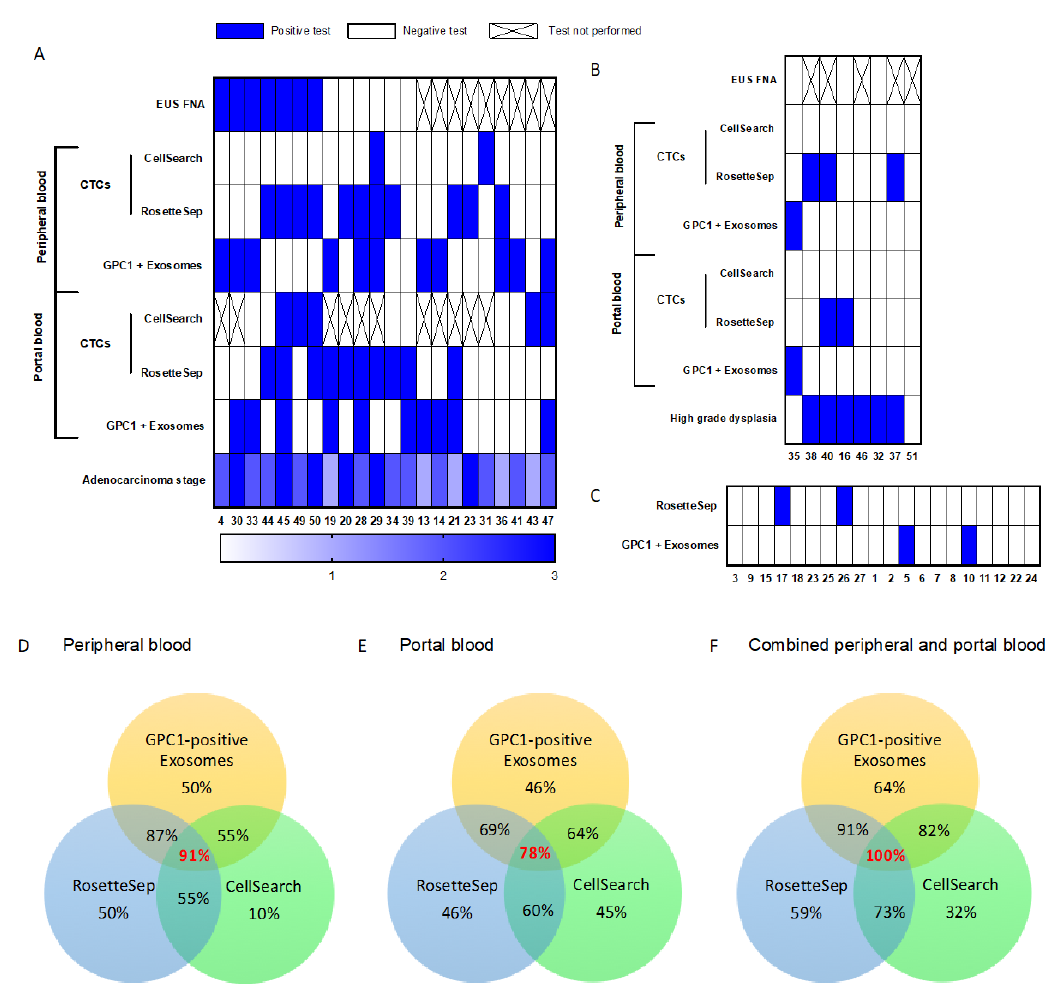
Figure 2. Heat maps of liquid biopsy results. ( A ) PDAC patients, ( B ) IPMN patients, and ( C ) noncancer control individuals. White rectangle: negative result, blue rectangle: positive result, crossed rectangle: not done. In the PDAC heat map, the bottom ladder indicates adenocarcinoma stage rankings from 1 to 3 according the stage of the disease (i.e., stage 1 light blue, stage 2 blue, stage 3 dark blue). In the IPMN heat map, the bottom ladder indicates dysplasia ranking from 0 (white box) for low grade dysplasia to 1 for high grade dysplasia (blue box). PDAC, pancreatic ductal adenocarcinoma; IPMN, intraductal papillary and mucinous neoplasm. ( D–F ) Venn diagrams recapitulating rates of CTC detection by CellSearch ® or RosetteSep TM -based enrichment and GPC1-positive-exosome quantification of ( D ) peripheral blood samples, ( E ) portal blood samples, ( F ) combined peripheral and portal blood samples.